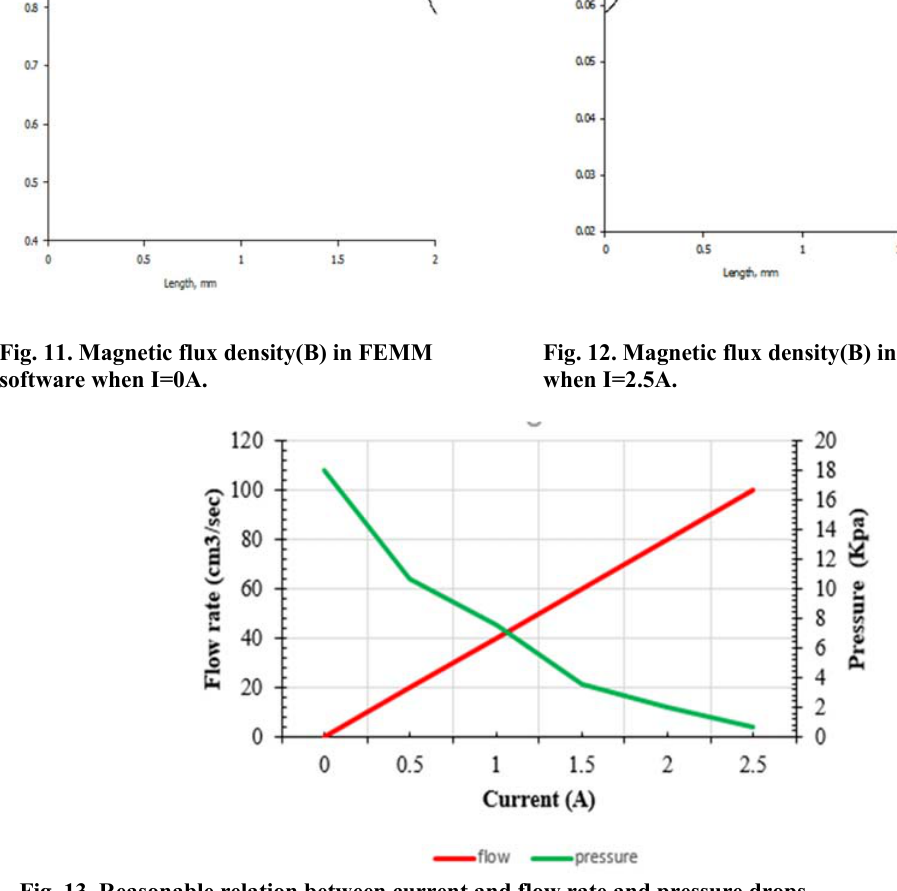
Fig. 13. Reasonable relation between current and flow rate and pressure